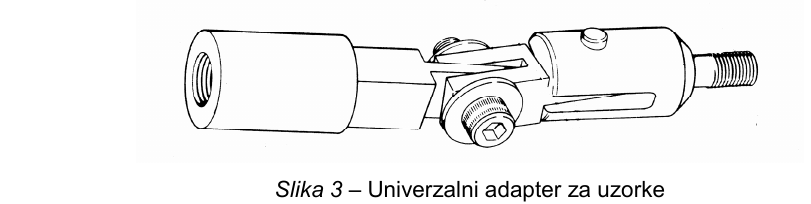
Figure 3 – Universal adapter for